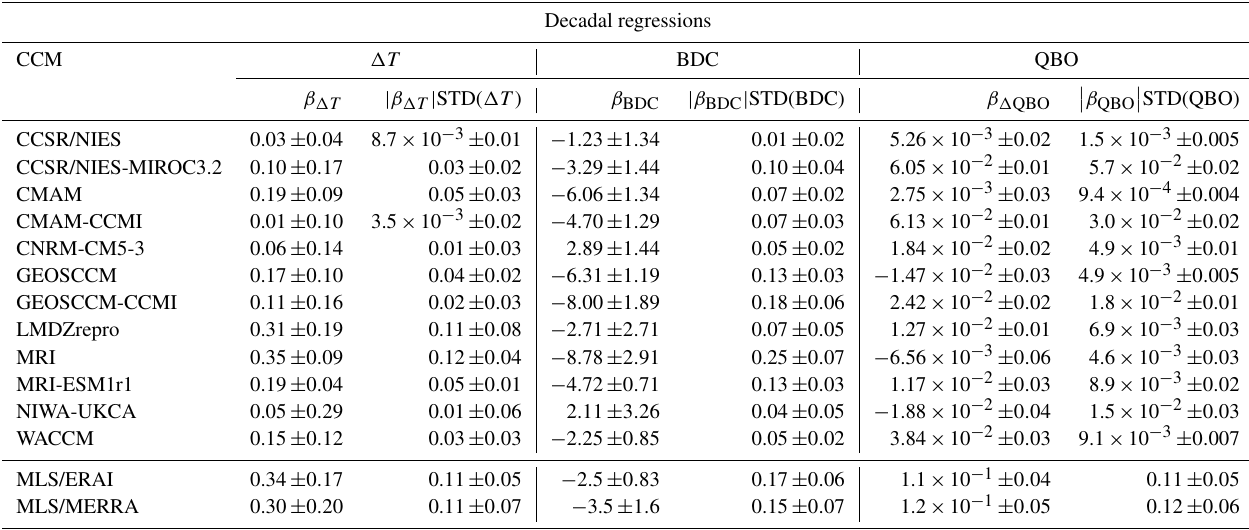
Figure 5. Circles represent the median of the adjusted R 2 value of the decadal fits. Errors correspond to the ± 1 standard deviation of the adjusted R 2 values. The CCM ensemble average is also plotted, along with error bars corresponding to ± 1 standard deviation of the ensemble set of decadal adjusted R 2 values. The lines are adjusted R 2 values from observations combined with reanalysis (ERAI (dotted) and MERRA (dashed)) from Dessler et al. (2014). Table 4. Median coefficients from the decadal regressions of [ H 2 O ] entry monthly anomalies, and the change in [ H 2 O ] entry resulting from each process ( β STD()), where STD() is the standard deviation of each decadal